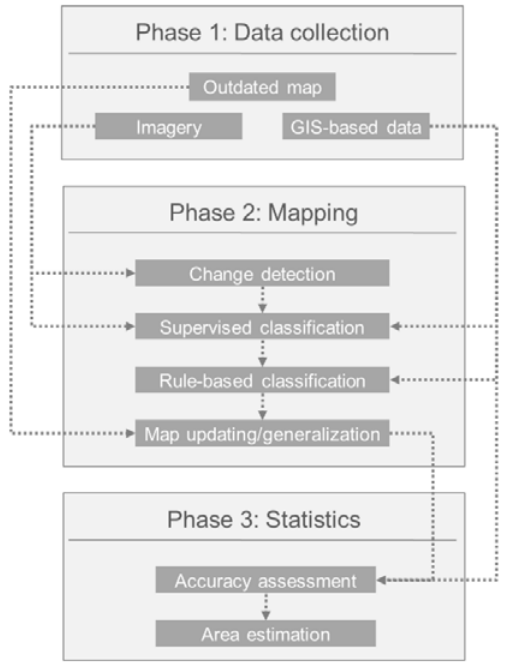
Figure 2. Framework overview.